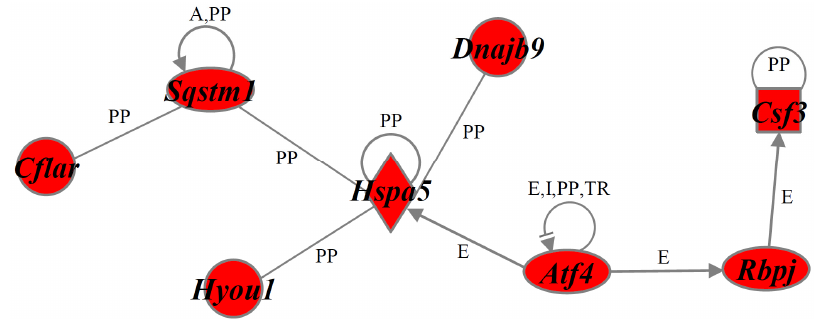
Figure 7. A gene network Up-II. Genes that were up-regulated in the cluster Up-II were analyzed by Ingenuity ® Pathway analysis software. For an explanation of the symbols and letters, see Figure